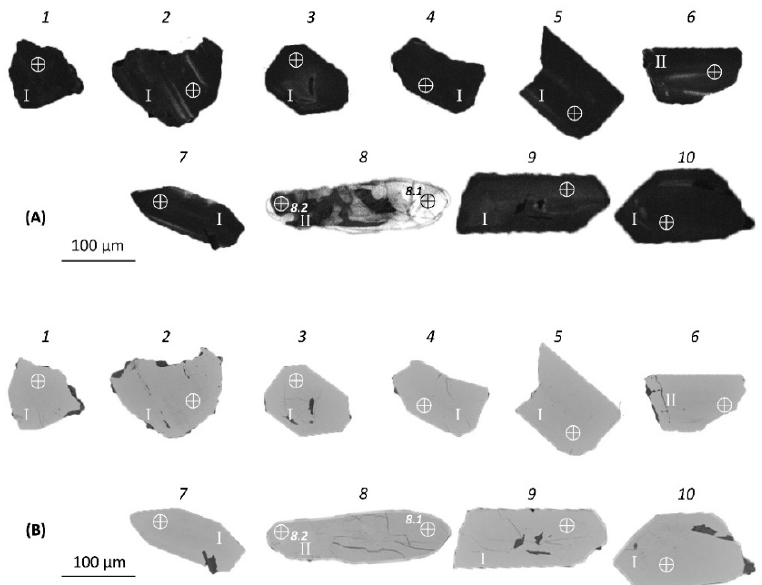
Figure 6. Images of different zircons from Sample BG29. ( A ) Cathodoluminescence (CL) images. ( B ) BSE images. Crosshairs on grains and Arabic numerals correspond to the points of analyses in Table 1; Roman numerals show zircon groups.